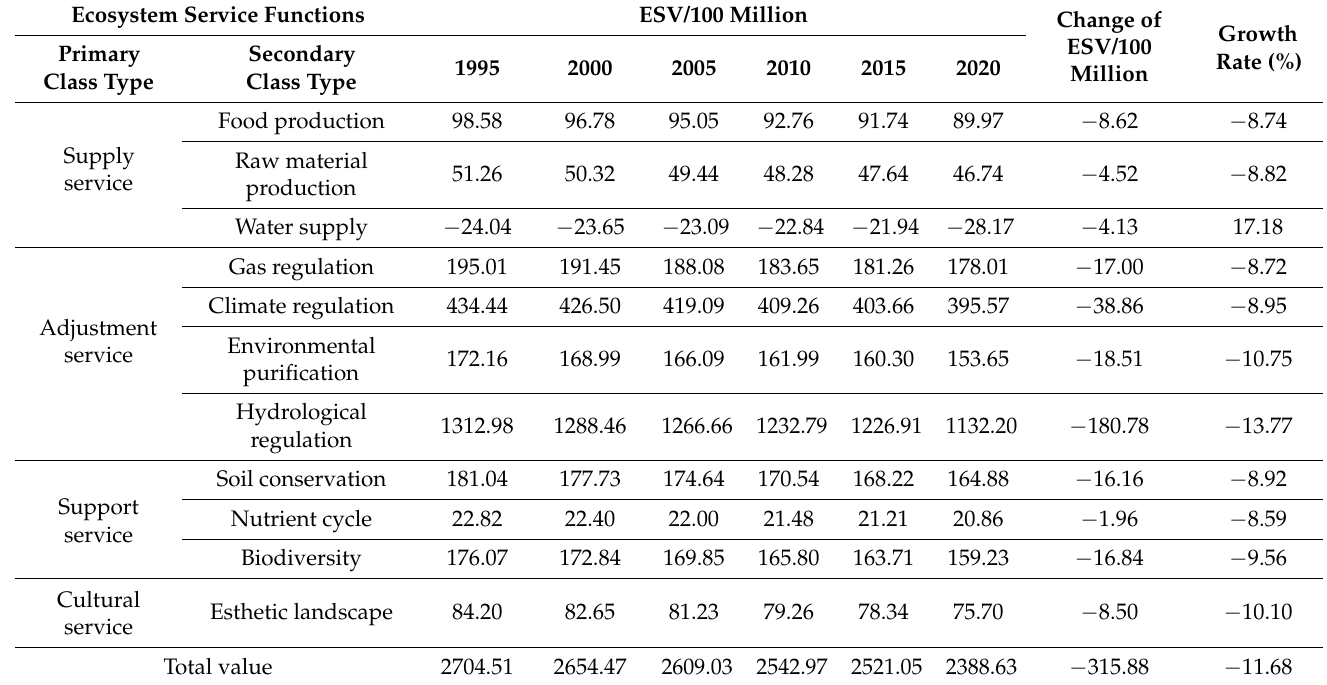
Table 3. Estimation of ecosystem service function values (ESV) in the Dongting Lake area from 1995 to